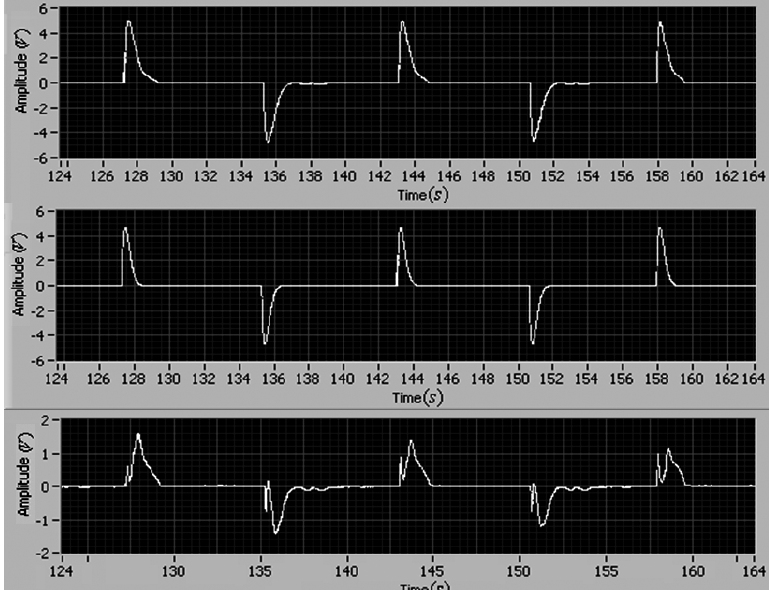
Figure 6. The reference velocity, the motor velocity and the tracking error ( i.e. , ( top) , (middle) and ( bottom) ,